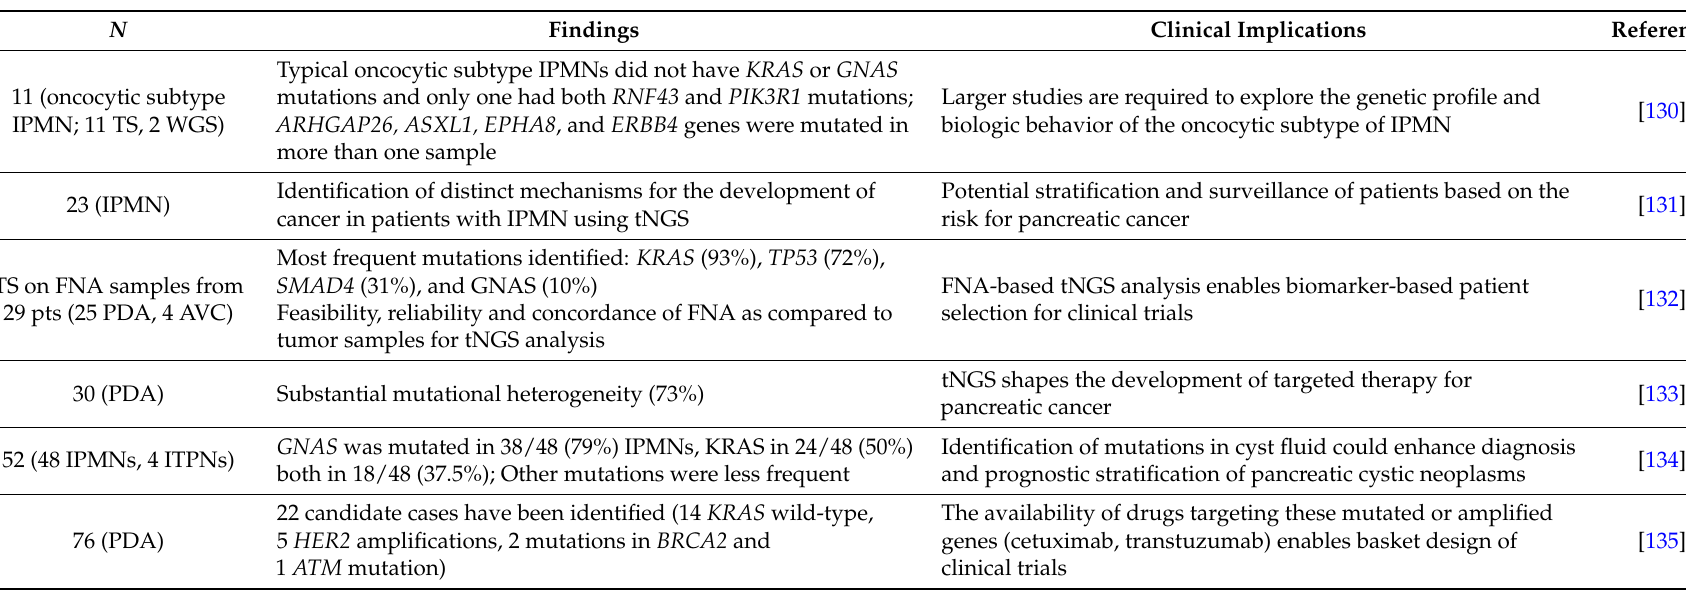
Table 7. Targeted next-generation sequencing studies on intraductal papillary mucinous neoplasms of the pancreas and pancreatic ductal